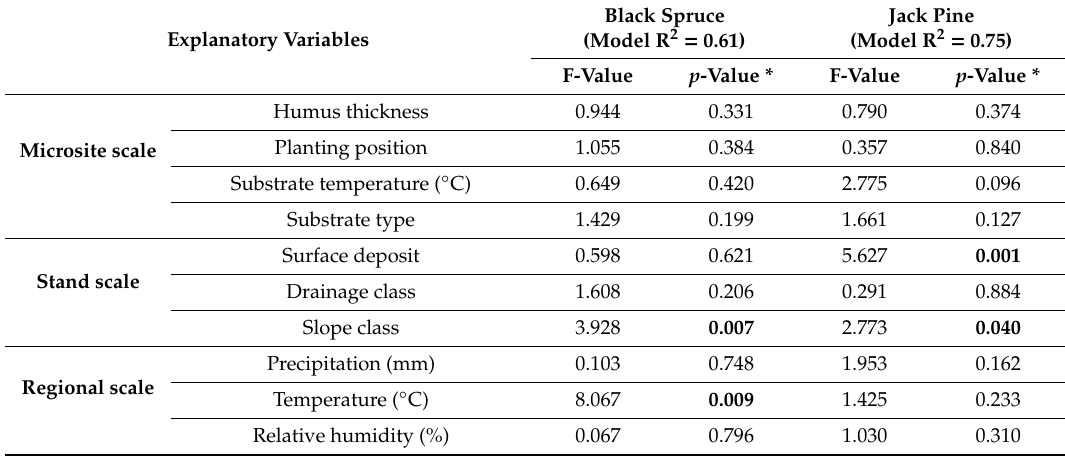
Table 2. ANOVA summary of the e ff ect of the explanatory variables and their interactions at three spatial scales on the relative growth volume of black spruce and jack pine seedlings in the boreal forest of